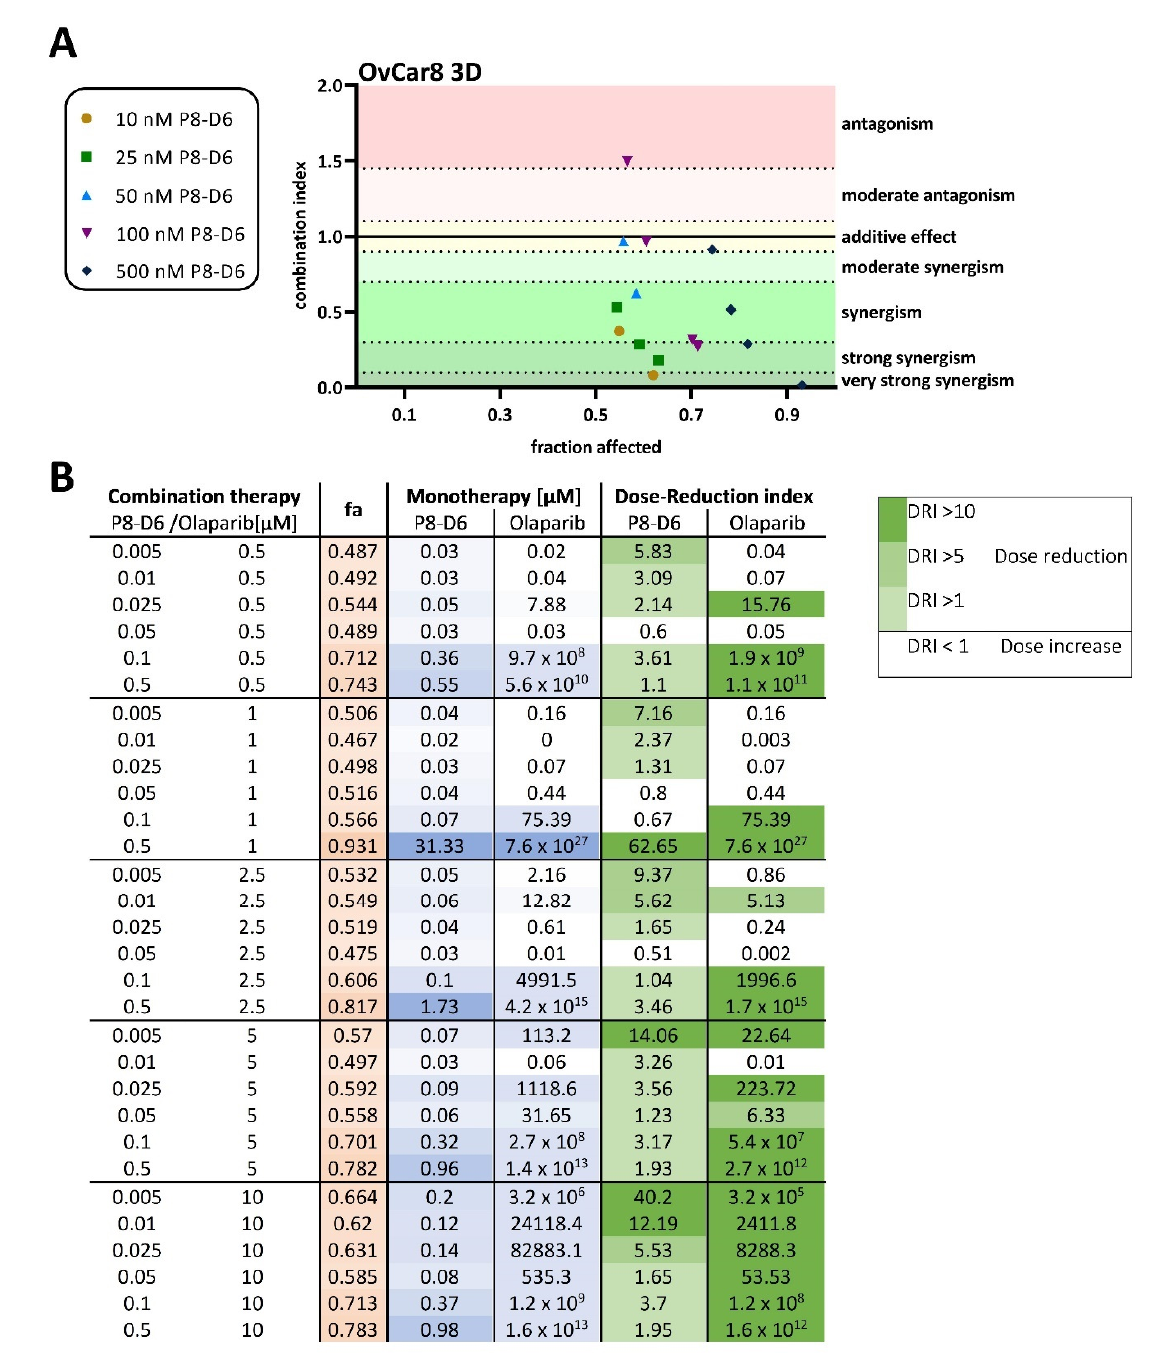
Figure 5. Combination index (CI) analysis of olaparib in combination with P8-D6 in OC spheroids. ( A ) Combination index (CI) for drug combinations by olaparib and P8-D6 in OvCar8 spheroids. CI values computed accordingly by CompuSyn software with viability values. Combinations were considered synergistic when CIs were below 1.0. The fraction affected (fa)-value represents the fraction of cell viability affected by therapy. ( B ) The monotherapy column defines the concentrations that are needed in monotherapy to affect a certain fraction of cells by therapy. DRI values represent the order of magnitude (fold) of dose reduction in combination setting compared with each drug alone.